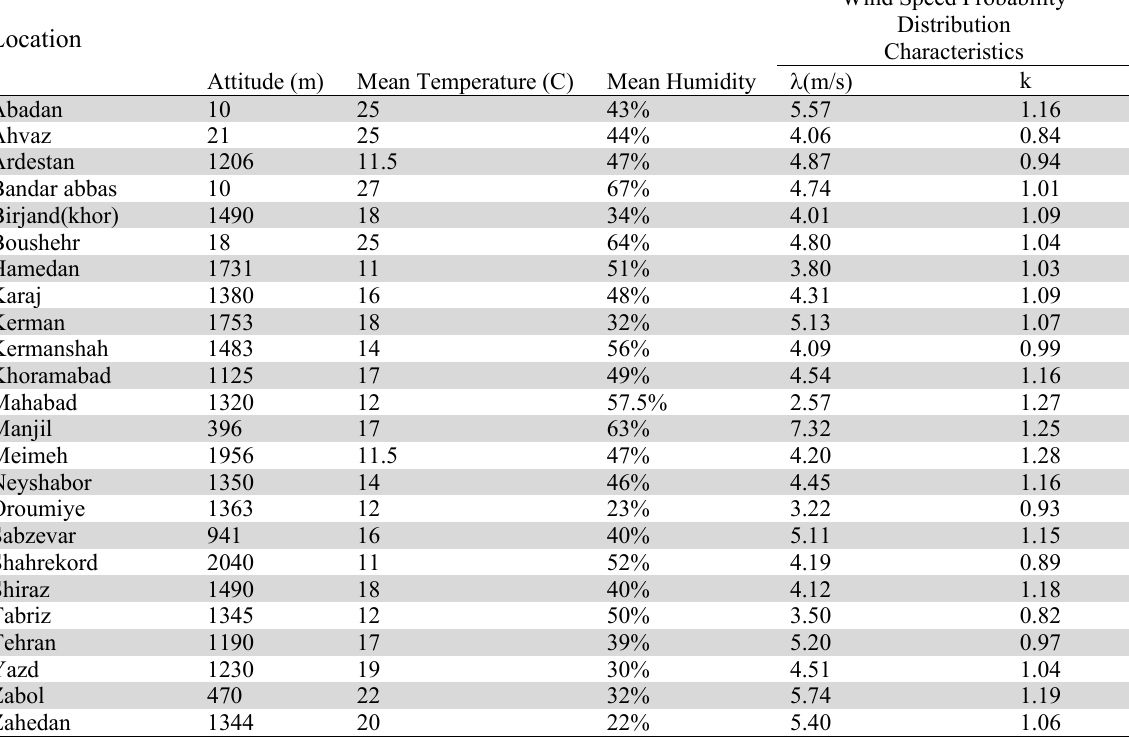
Values of parameters of simulation phase Location